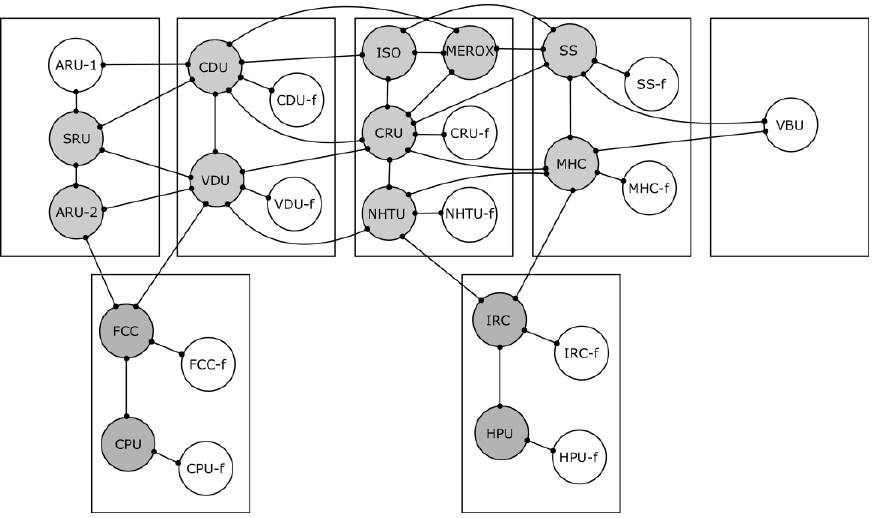
Figure 5. Graph illustrating allowed heat integration opportunities (indicated by edges between circles) when integration is allowed between adjacent units within the same area and as well as between adjacent areas (case d).